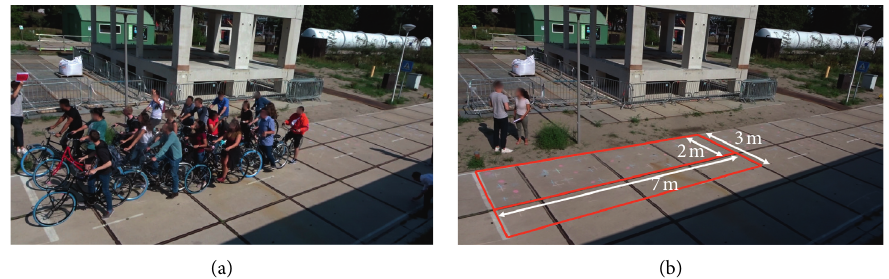
Figure 7: Example of a queuing event in the experiment (a) and cleared path showing the waiting area indicated with red lines (b).